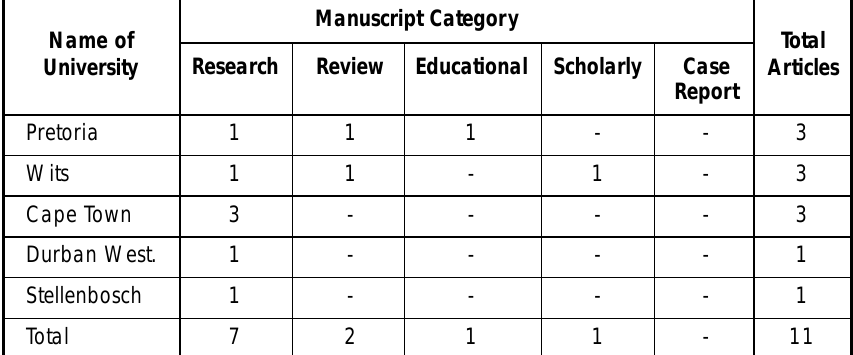
Table 2: Articles by South African Physiotherapy academics during 2002 (n =